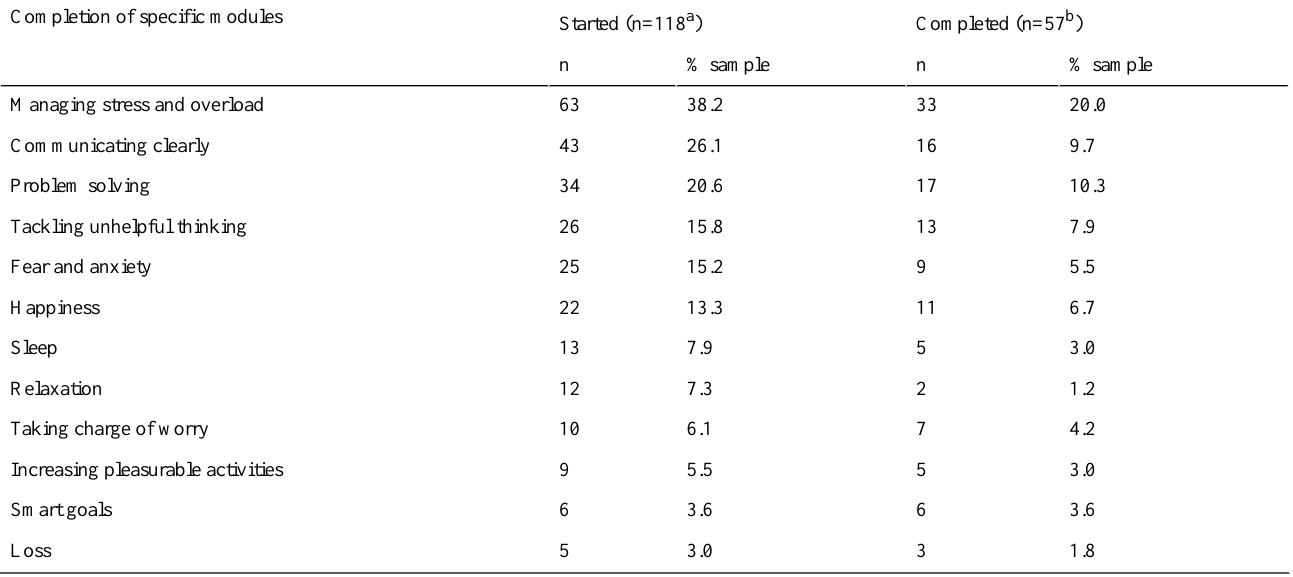
Table 1. Module usage statistics (n=165).